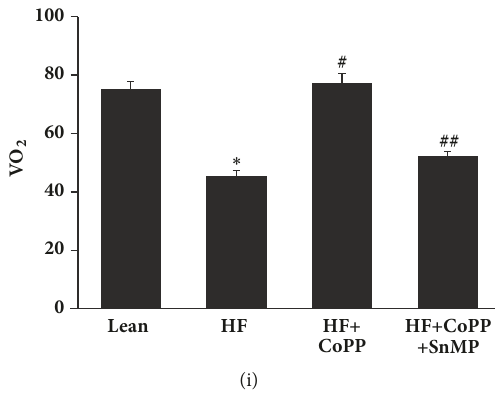
Figure 4: Increase of HO-1 expression augments mitochondrial integrity. mRNA expression of (a) MFN1, (b) MFN2, (c) OPA1, and (d) FIS1. (e) Representative western blots and densitometric analysis of (f) COX2, (g) COX4, and (h) ATP synthase. (i) Total body oxygen consumption (VO 2 ) of mice, in hepatic tissues of control lean mice, HF fed mice, HF fed mice + CoPP, and HF fed mice + CoPP + SnMP. Results are mean ± SE, n=6, ∗ p < 0.05 versus lean mice, #p < 0.05 versus HF fed mice, and ##p < 0.05 versus HF fed mice + CoPP.